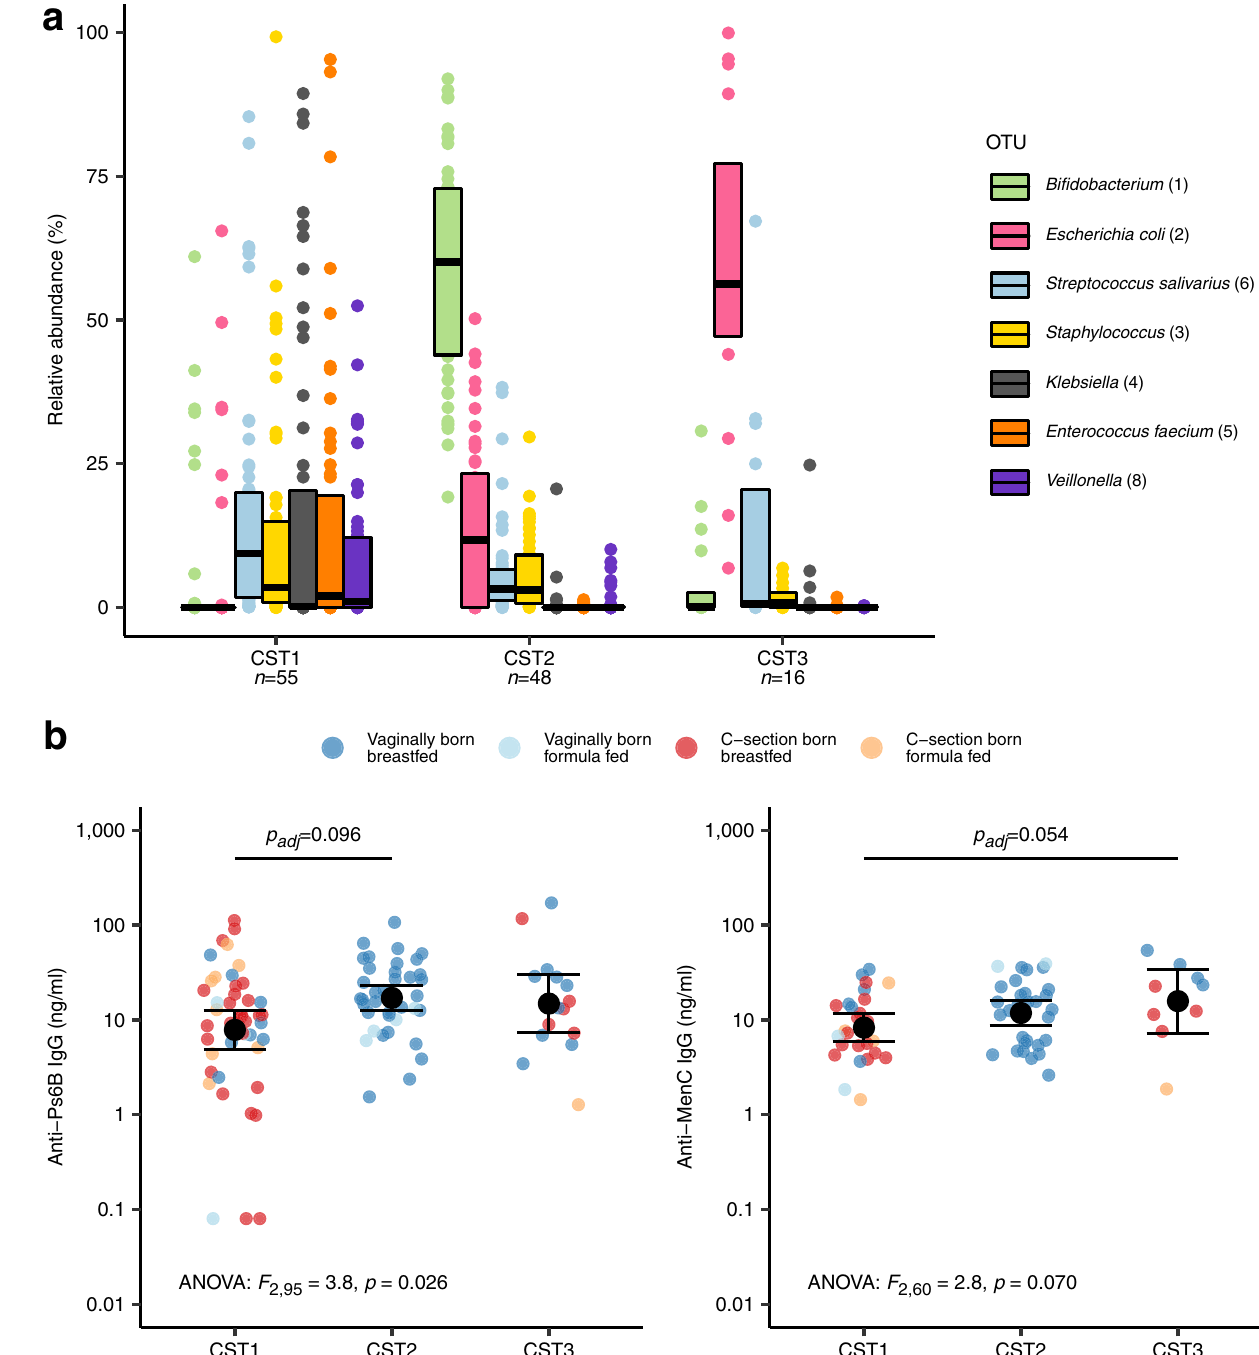
Fig. 3 | Gut microbial community state types at week 1 and anti-Ps6B and anti- MenC IgG concentrations. a Boxplot of relative abundances of the top 7 opera- tionaltaxonomicunits(OTUs)percommunitystatetype(CST)de fi nedat1weekof age.Boxesshowmedianswithinterquartileranges. b CSTsareplottedagainstanti- Ps6B IgG concentrations (left) and anti-MenC IgG concentrations (right). Dots are